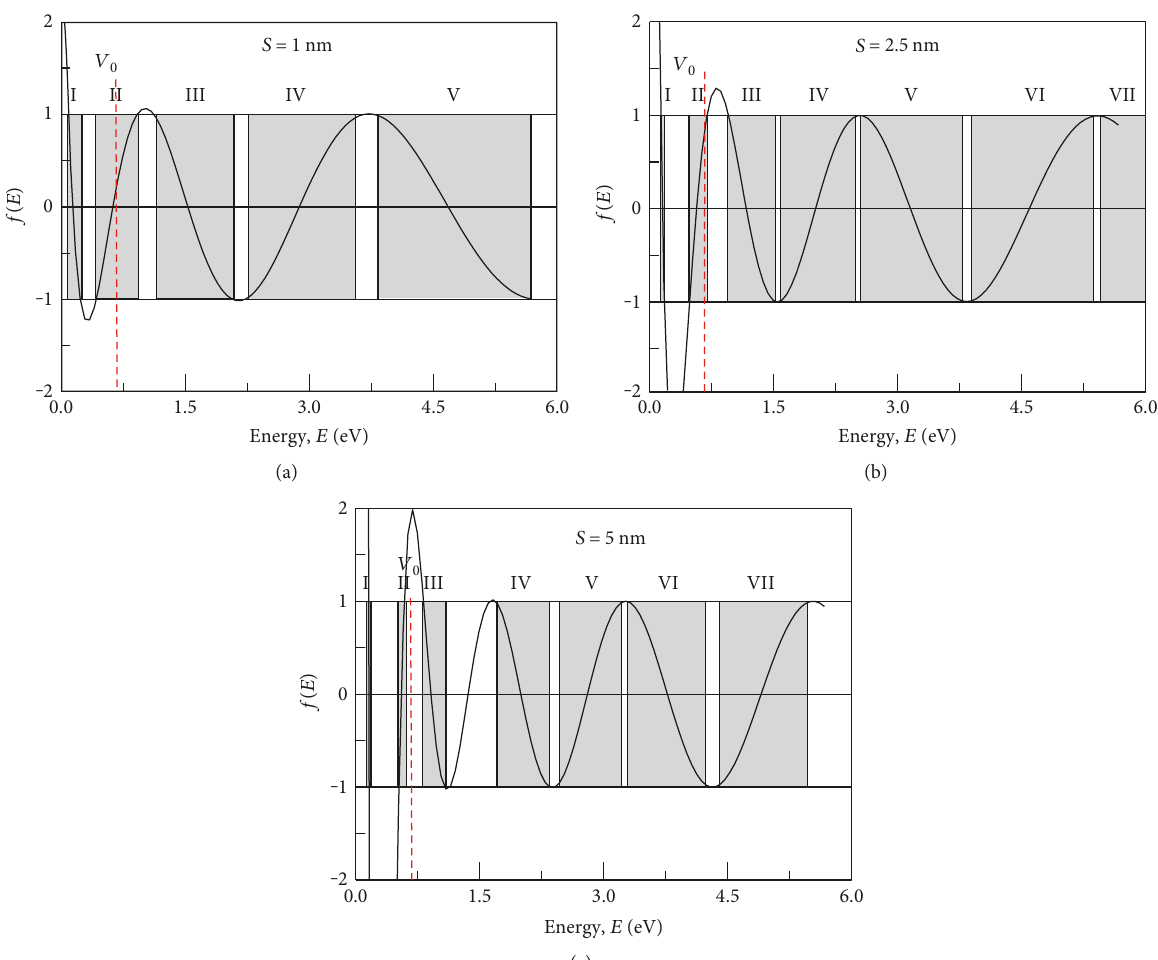
Figure 2: Miniband dispersion in In